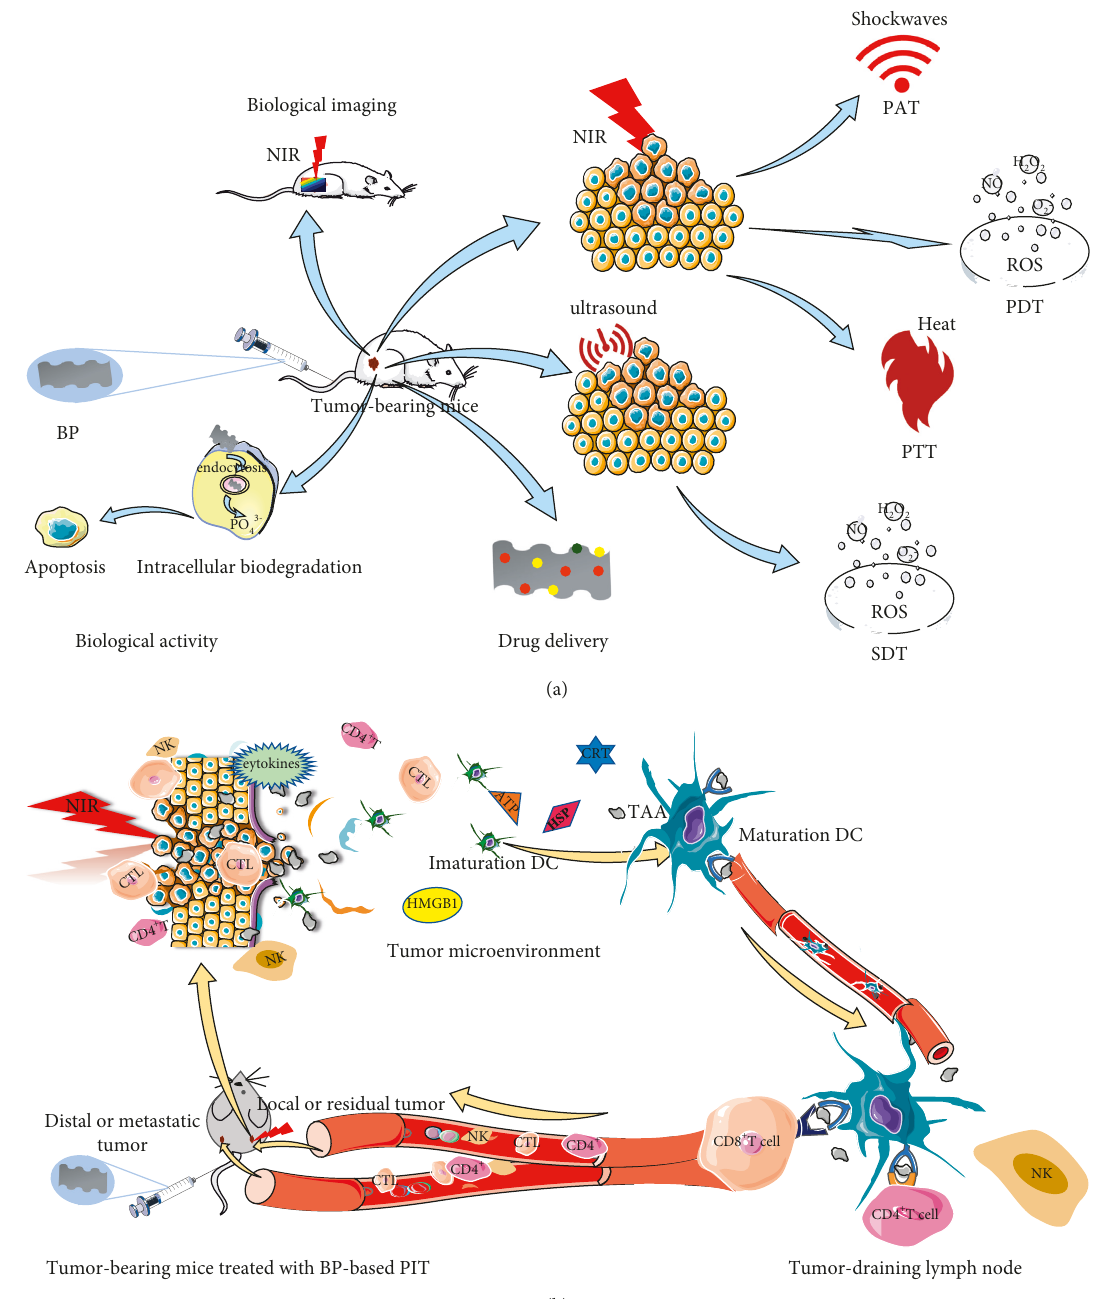
Figure 5: The application of BP in biomedicine. (a)BP exhibit natural antitumor biological activity, biological imaging, drug delivery, and phototherapy (including PAT, PDT, and PTT). (b) PIT is induced by BP. Shockwaves, ROS, or heat activated by BP with INR irradiation cause structural damage of tumor cells. These damaged tumor cells release TAA, which facilitates the construction of in situ vaccines. This in situ vaccine promotes the maturation of DC, which induced the generation, proliferation, and infiltration of cytotoxic T cells benefit by DAMPs (including CRT, ATP, HMGB1, and HSPs). Abbreviations: BP, black phosphorus; PTT, photothermal therapy; PDT, photo- dynamic therapy; SDT, sonodynamic therapy; PAT, photoacoustic therapy; PIT, photoimmunotherapy; ROS, reactive oxygen species; NIR, near-infrared; TAAs, tumor-associated antigens; DCs, dendritic cells; CTLs, antigen-specific cytotoxic Tcells; DAMPs, damage-associated molecular patterns; CRT, calreticulin; ATP, adenosine triphosphate; HMGB1, high-mobility group box 1; HSPs, heat shock